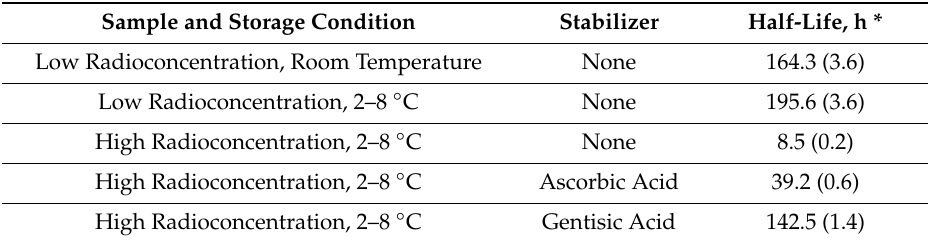
Table 1. Summary of half-life of degradation (t 1 / 2 , h) of low and high-radioconcentration samples of 177 Lu-Labeled RM1 in acetate bu ff er stored at room temperature and 2–8 ◦